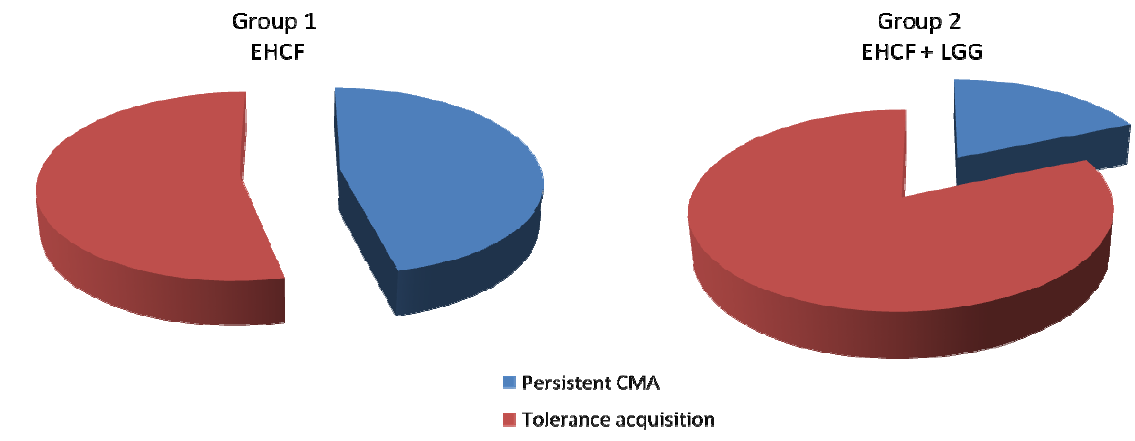
Figure 2. Lactobacillus GG accelerates tolerance acquisition in infants with cow’s milk allergy. Rate of patients with documented tolerance acquisition at the double blind placebo controlled food challenge after 12 months of diet therapy with an extensively hydrolyzed casein formula (EHCF) or with an extensively hydrolyzed casein formula containing LGG (EHCF+LGG) (modified from reference